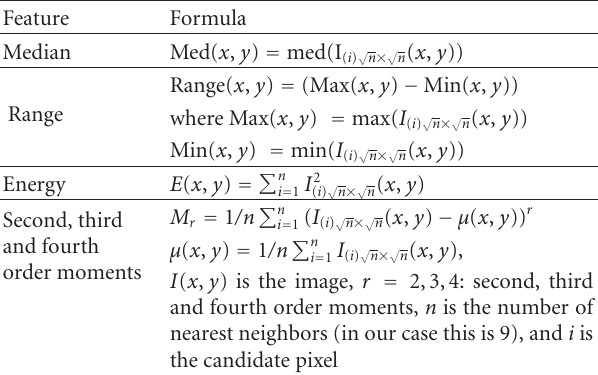
Table 1: Six statistical features generated from the 3 × 3 intensity neighborhood of a candidate pixel.